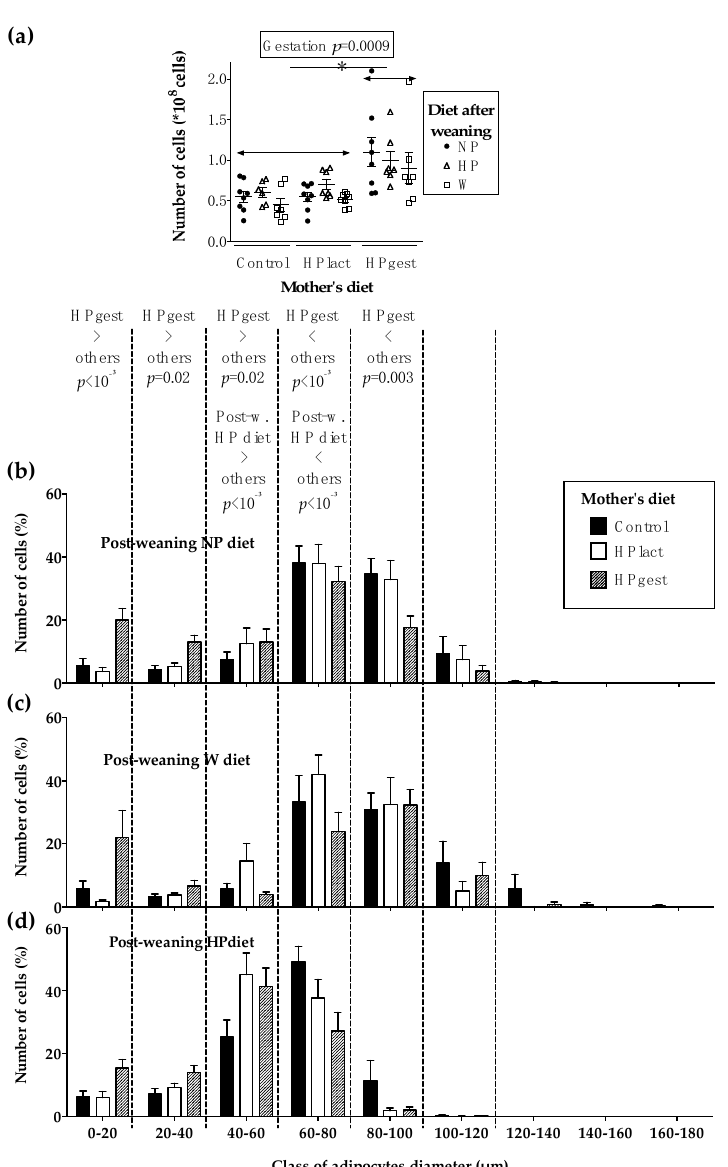
Figure 3. Adipocytes in peri-ovarian adipose tissue of female rat pups at PND70. Number of adipocytes in total peri-ovarian adipose tissue ( a ) and peri-ovarian adipocyte size of pups receiving the post-weaning NP diet ( b ), W diet ( c ) and HP diet ( d ). Data are represented as means ± SEM with individual values for (a), ( n = 8). Effects of diets, time and their interactions were tested within mixed Model 1.